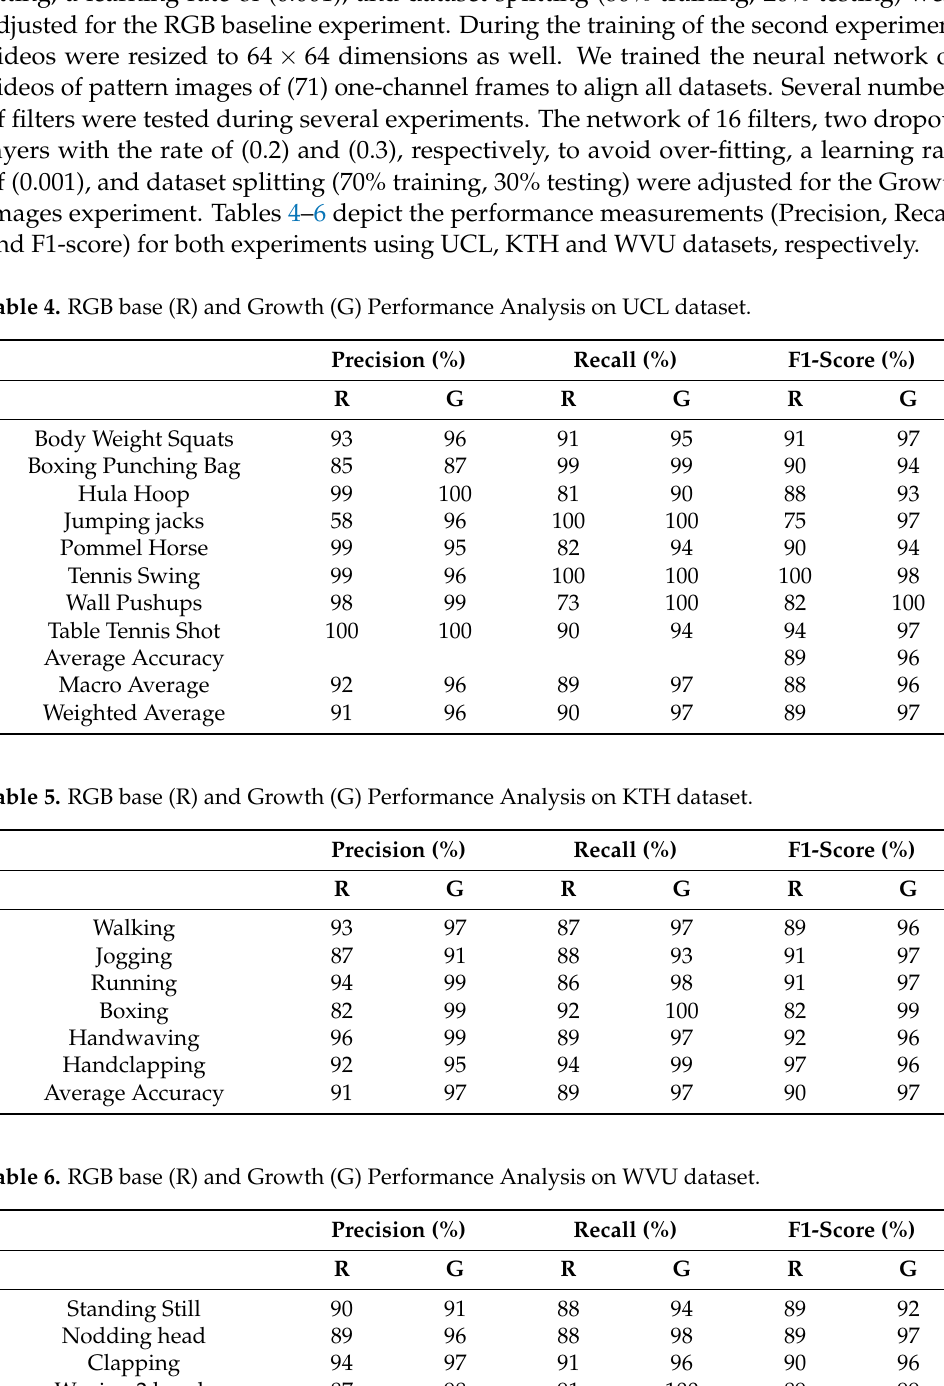
Table 4. RGB base (R) and Growth (G) Performance Analysis on UCL dataset.